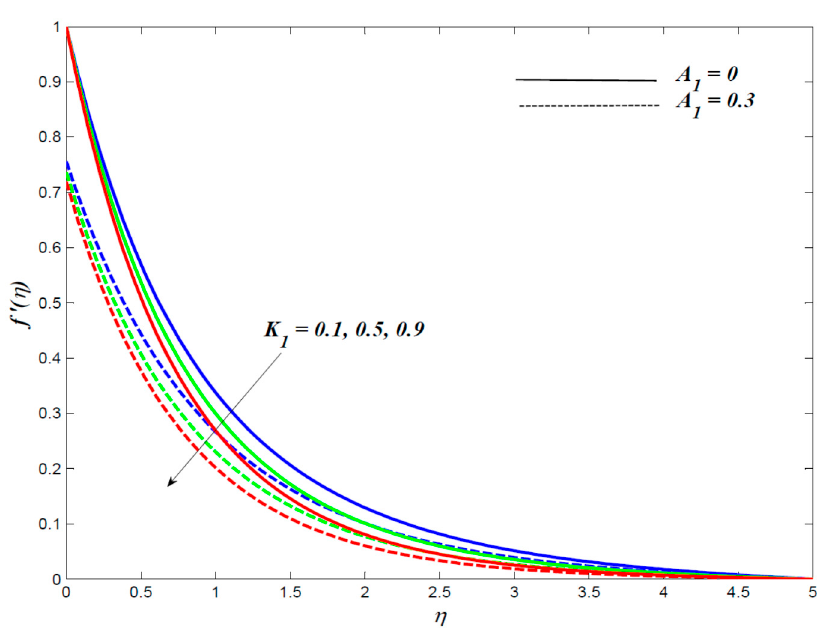
Figure 3. Velocity profiles owing to varying values of K 1 .